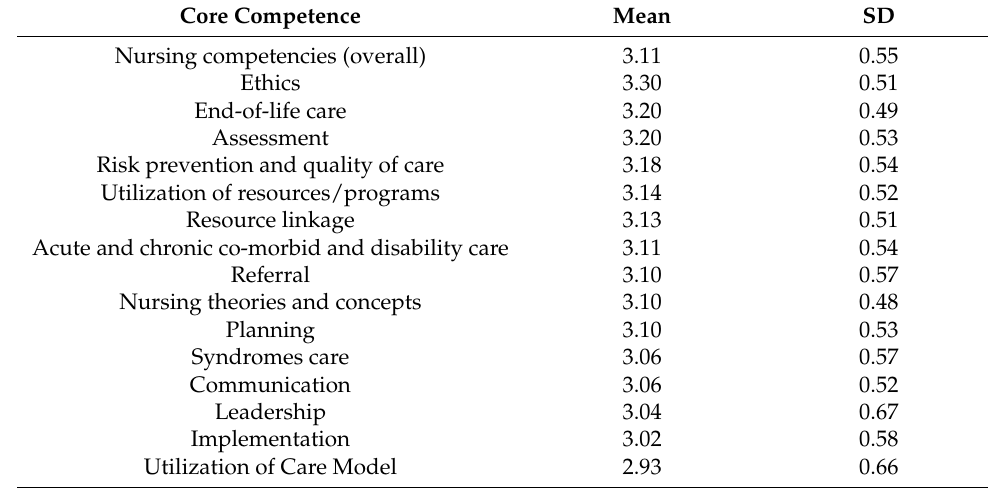
Table 2. Difference analysis of the nurses’ competence in nursing care (N = 333).